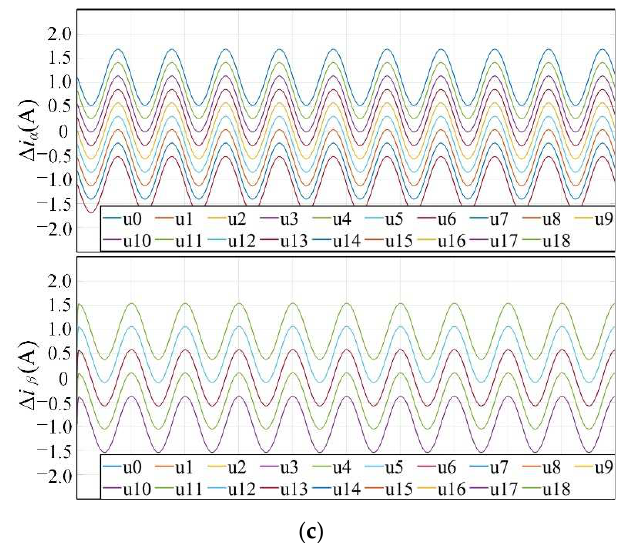
Figure 8. Current gradient comparisons under different updating methods ( i ref = 5A). ( a ) Updating method in [20]. ( b ) Updating method in [30]. ( c ) The proposed updating method.